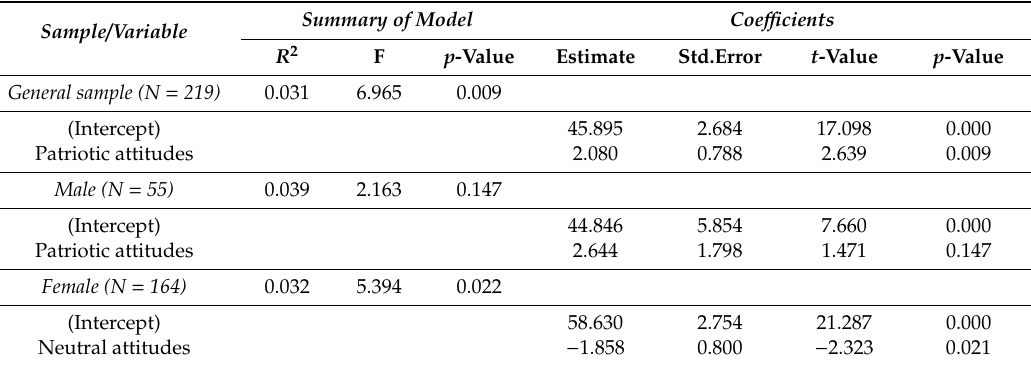
Table 3. Best predictor regression models for Ambivalence subscale of ISS.